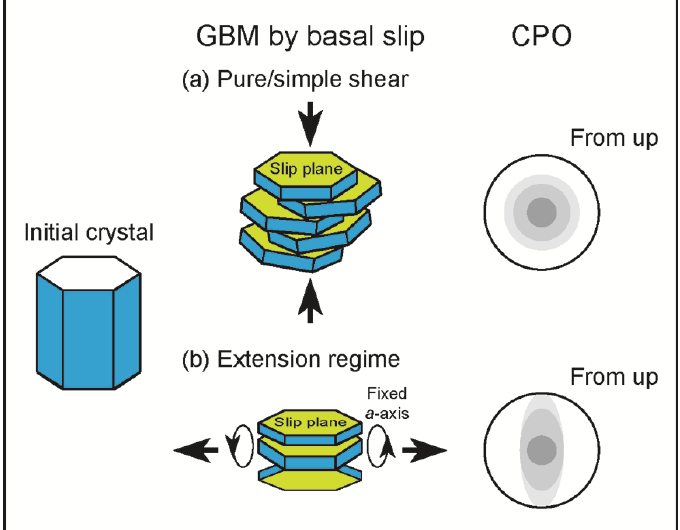
Figure 9. Schematic model to show formation of a single cluster with ( a ) weak maxima around the cluster under a compressional (pure/simple shear) regime, and ( b ) the weak aligned maxima (a girdle) under an extension regime.